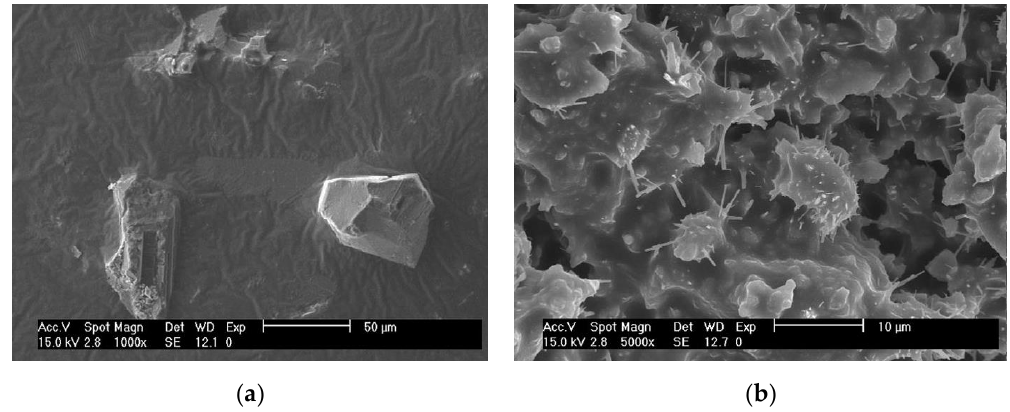
Figure 6. SEM images of ( a ) Mineral filler-asphalt mastic and ( b ) Cement-residue mastic.